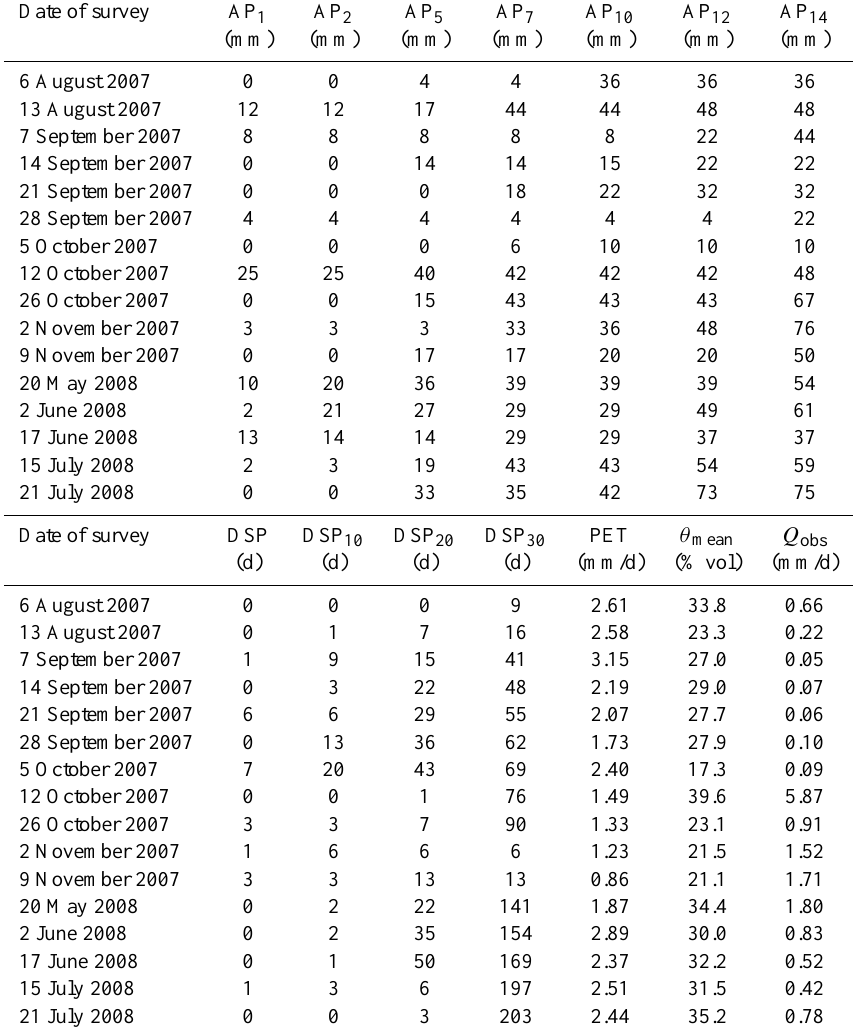
Table 2. Surrogates for AMCs, catchment macrostate and hydrologic response for 16 soil moisture surveys in the Hermine. See meaning of abbreviations in